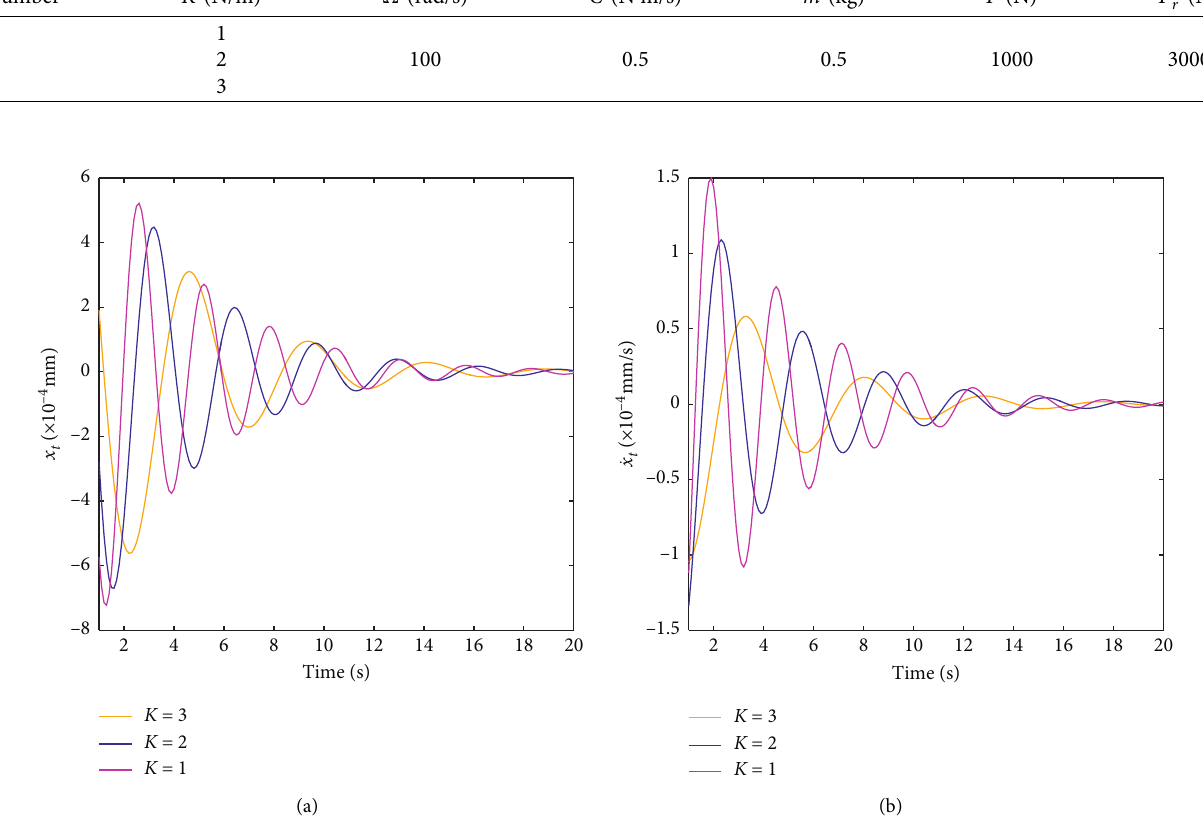
Figure 3: Changes of movement displacement (a) and movement velocity (b) of rock surface with time in different k .